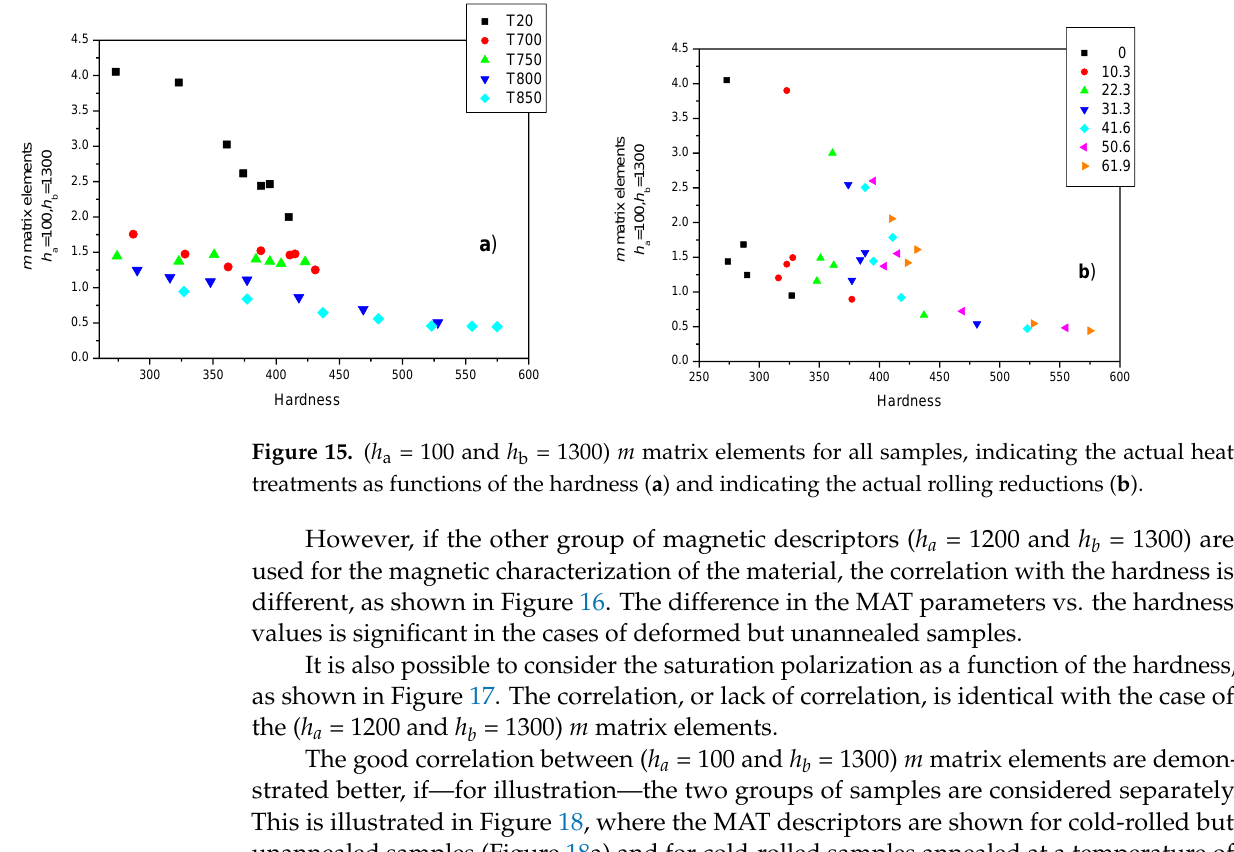
Figure 16 . ( h a = 1200 and h b = 1300) m matrix elements for all samples, indicating the actual heat treatments as functions of the hardness. It is also possible to consider the saturation polarization as a function of the hardness, as shown in Figure 17. The correlation, or lack of correlation, is iden- tical with the case of the ( h a = 1200 and h b = 1300) m matrix elements. 250 Hardness Figure 17. Saturation polarizations of all samples, indicating the actual heat treatments ( a ) and the rolling reductions ( b ) as functions of the hardness.